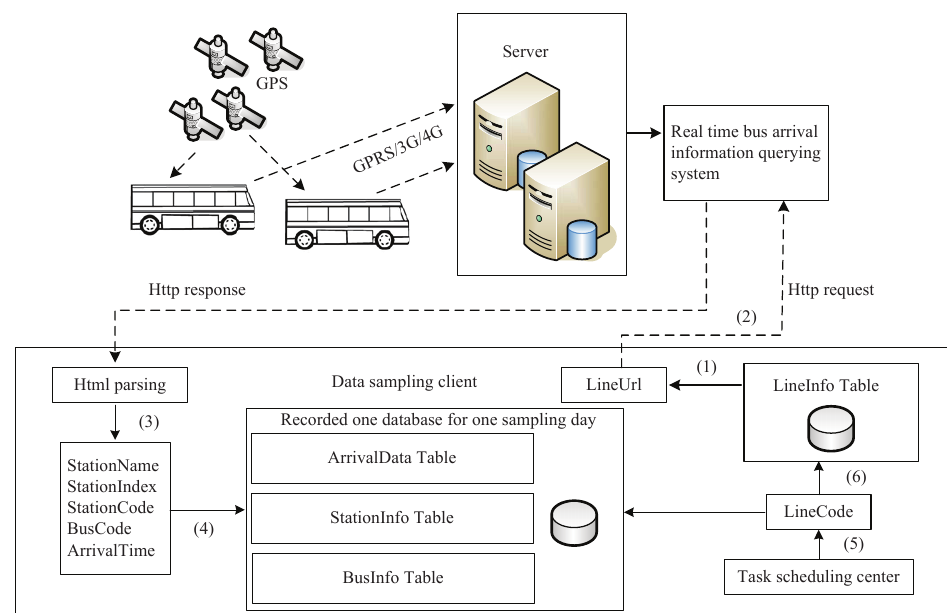
Figure 3. Flowchart of the bus arrival data acquisition